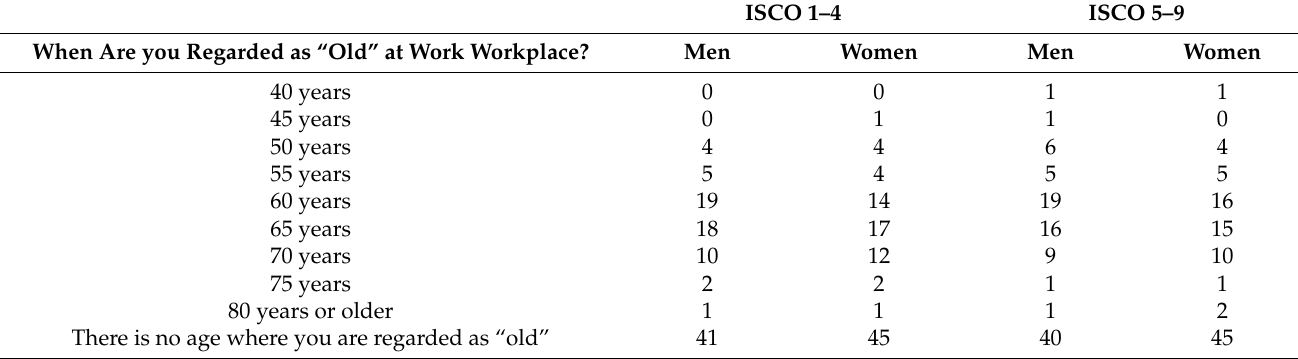
Table 2. Proportion of respondents (%) reporting that you are regarded as “old” at the respective ages divided by ISCO group and